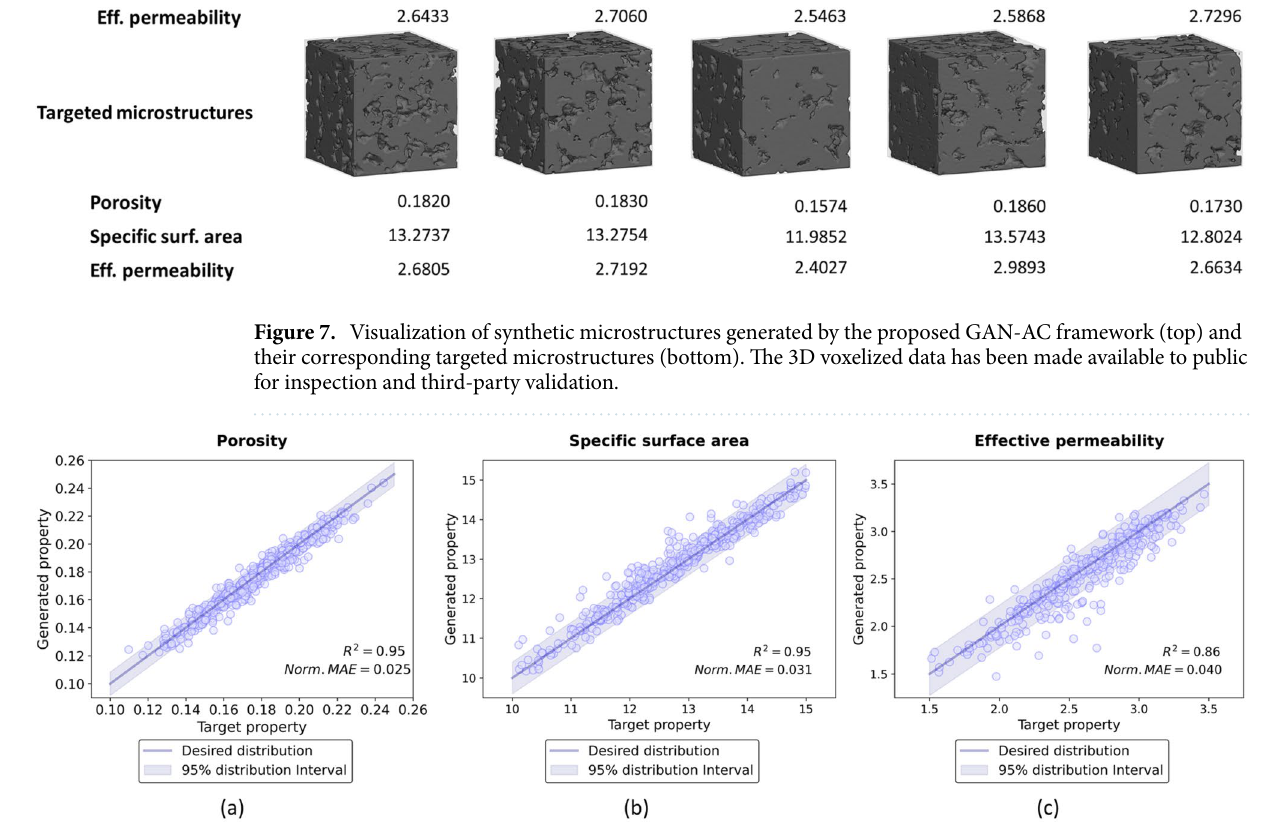
Figure 8. Comparison between targeted and generated properties. On the test conducted on 500 examples that were set aside during training, synthetic microstructures generated by the GAN-AC framework exhibited the targeted physical properties with extremely small difference, 2.54, 3.51, and 4.06% for porosity, specific surface area, and effective permeability,